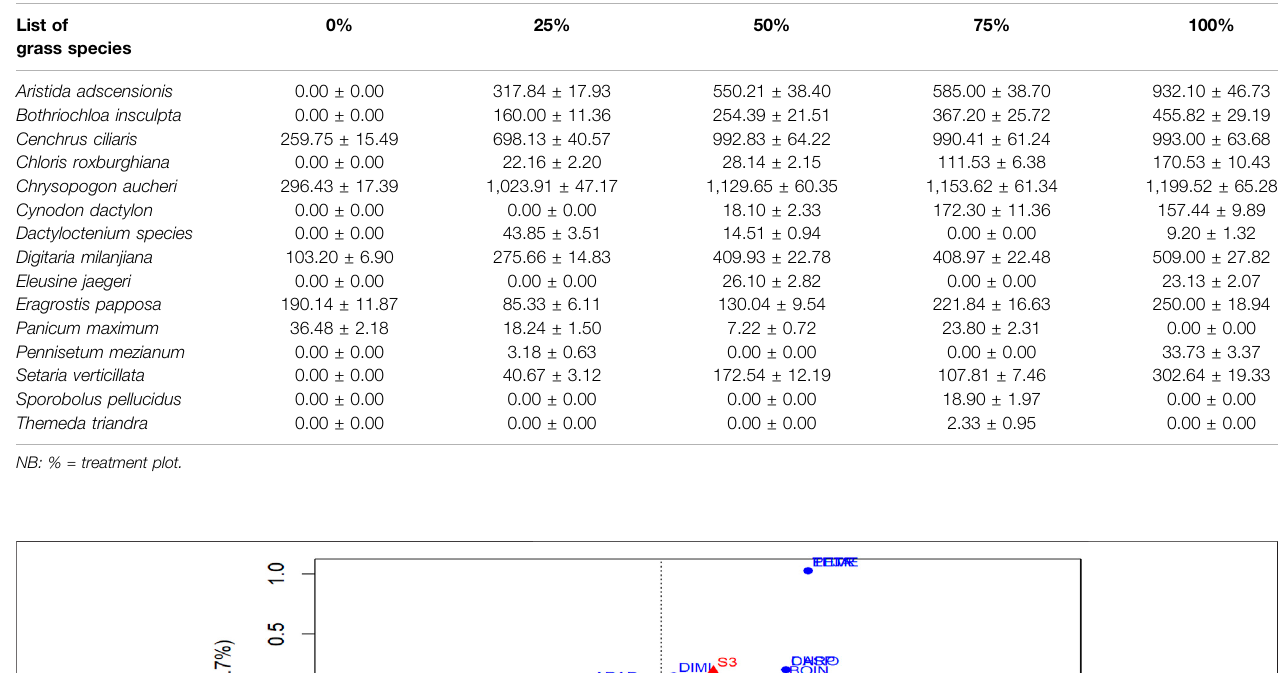
TABLE 3 | Mean ( ± SE) biomass productivity (Kg. ha − 1 ) of the individual grass species along the thinning gradient in the savanna of southern Ethiopia. List of grass species